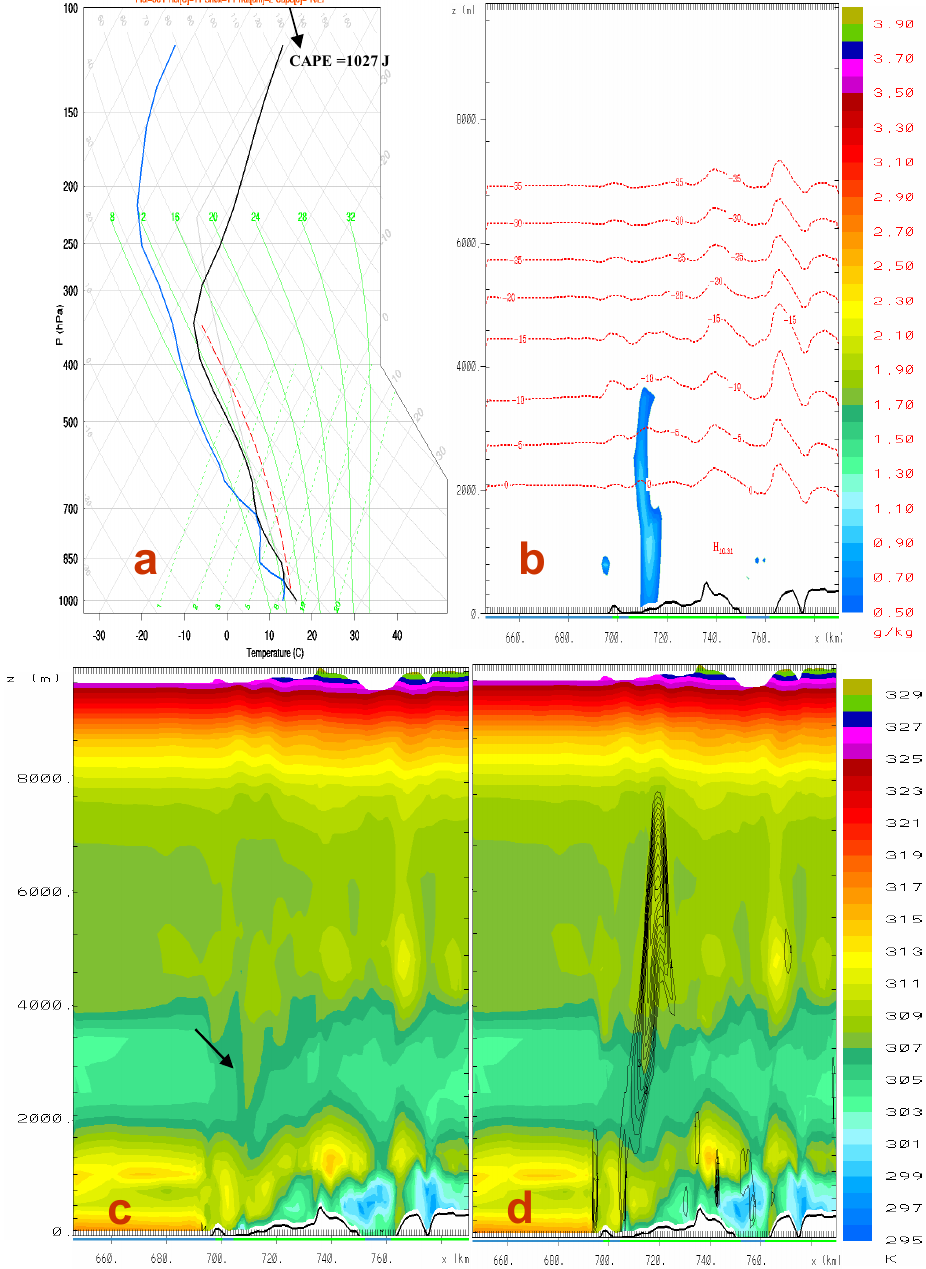
Fig. 12. (a) Modelled thermodynamic profile of the atmosphere over Haifa at 08:20 UTC, 29 January 2003 and W-E cross sections over Haifa for: (b) Liquid water mixing ratio (colour palette in gkg − 1 ) and ambient temperature (red contours in C ◦ ) at 08:20UTC. (c) Equivalent potential temperature (colour palette in K) at 08:20UTC. The arrow points at the area of increased θ e . (d) Equivalent potential temperature (colour palette in K) and updrafts (black contours in ms − 1 ) at 08:30UTC. The plots refer to